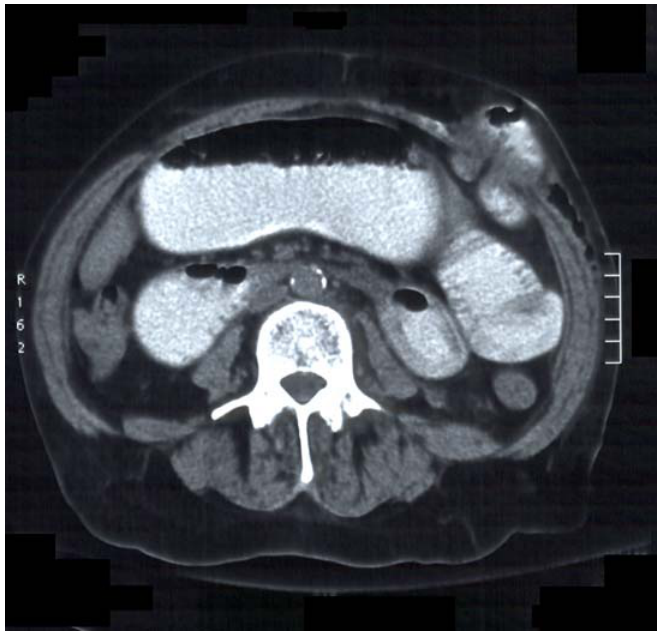
FIGURE 1. Abdominal CT revealing herniation of small bowel at the location of the left lower 12-mm port